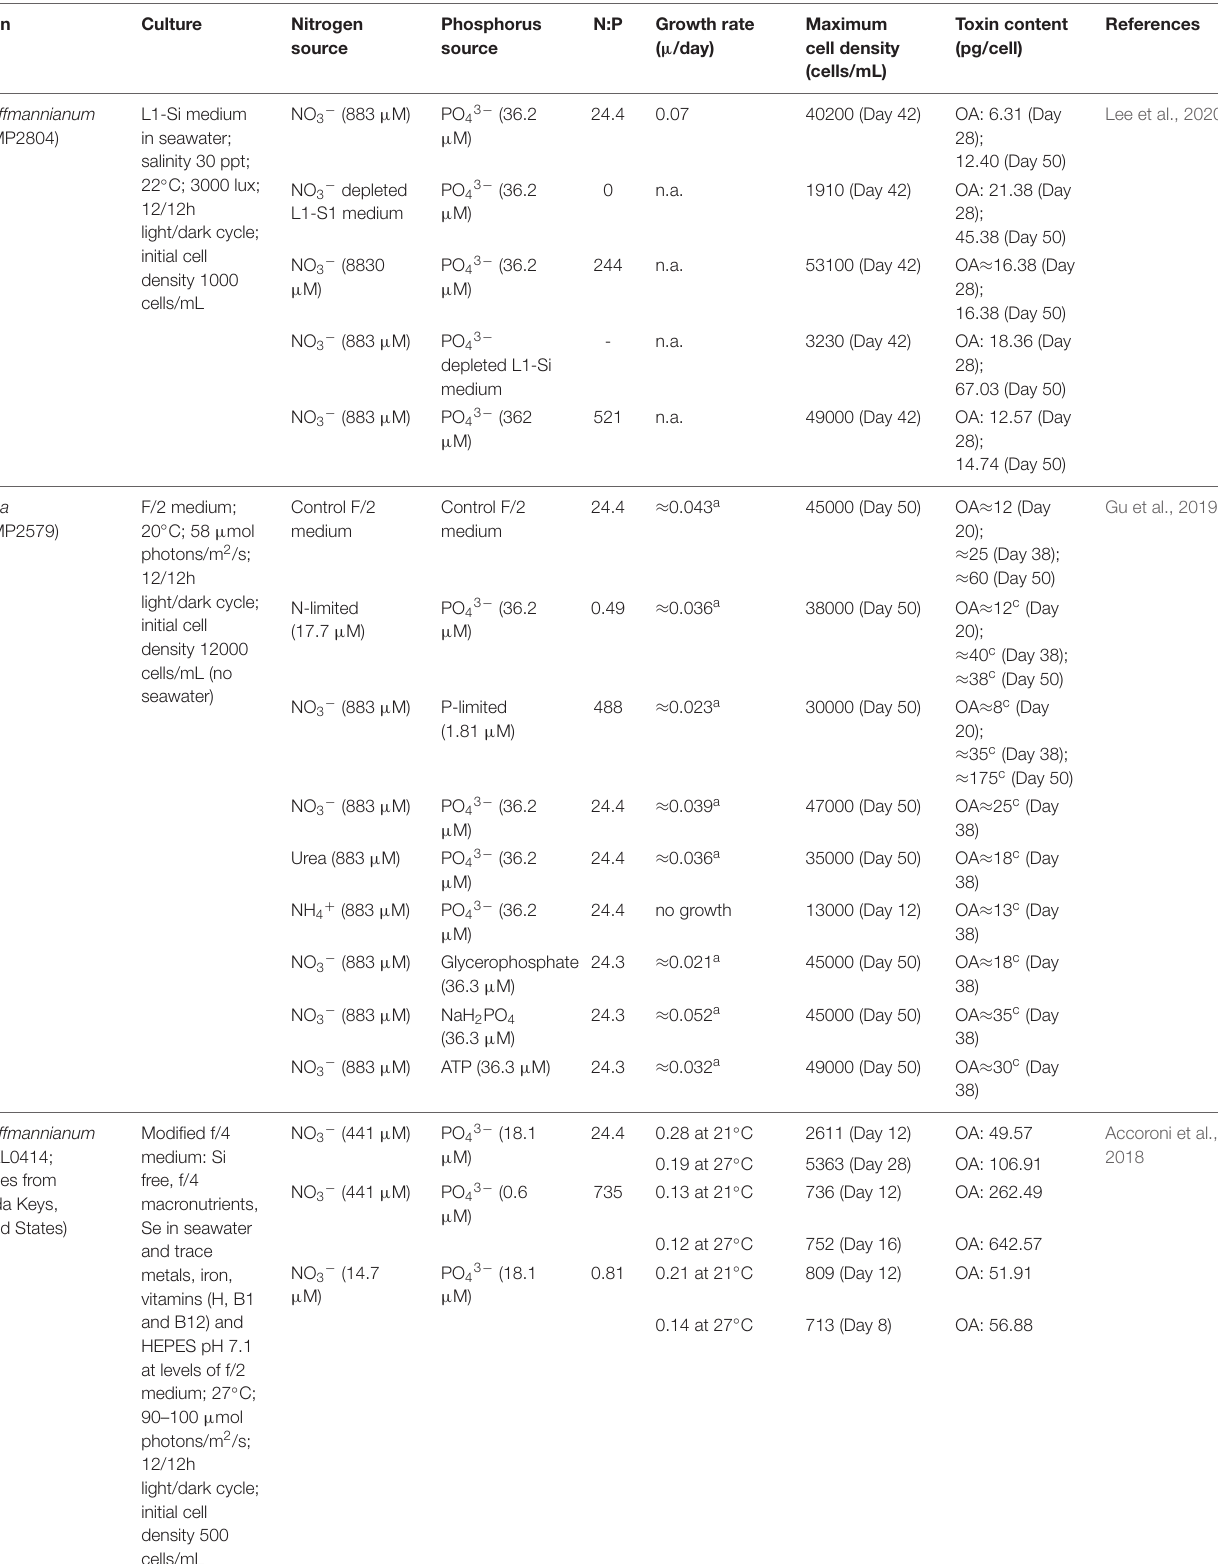
TABLE 2 | Effect of nitrogen and phosphorus on the growth and toxin content of Prorocentrum spp. Strain Culture Nitrogen